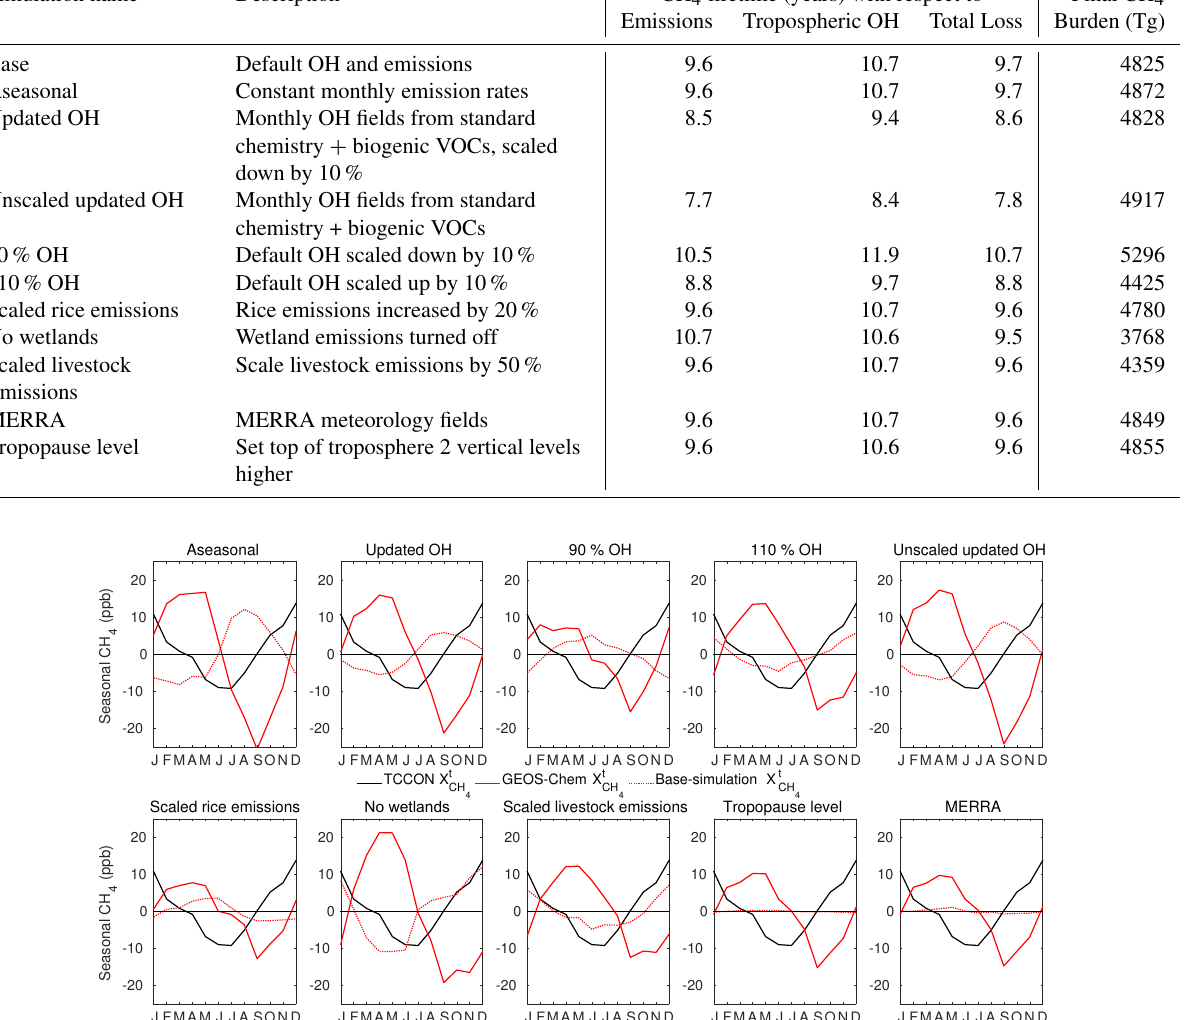
Figure B3. Seasonality of tropospheric methane ( X t ) at Park Falls for TCCON (black solid line), GEOS-Chem (red solid line), and the CH 4 difference from the base simulation (dotted red line) for each of the sensitivity experiments, in